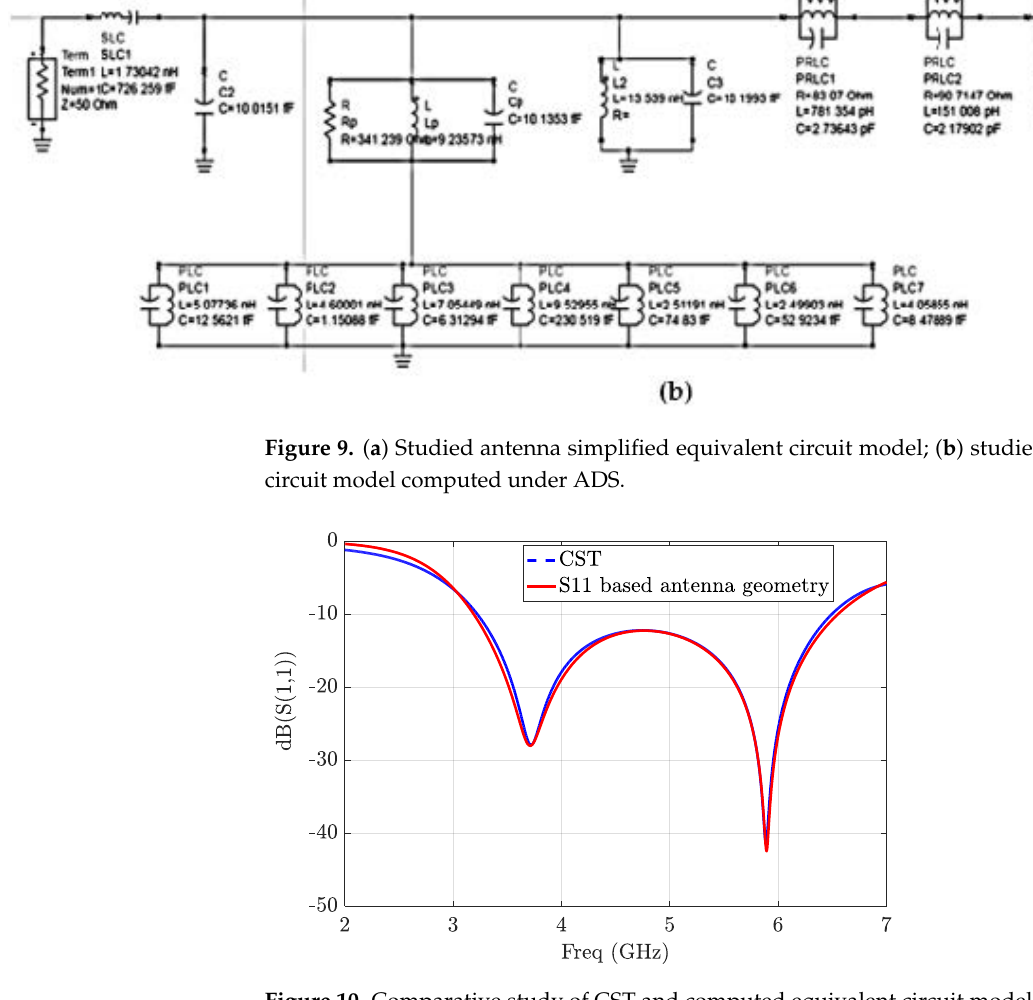
Figure 10. Comparative study of CST and computed equivalent circuit model results.